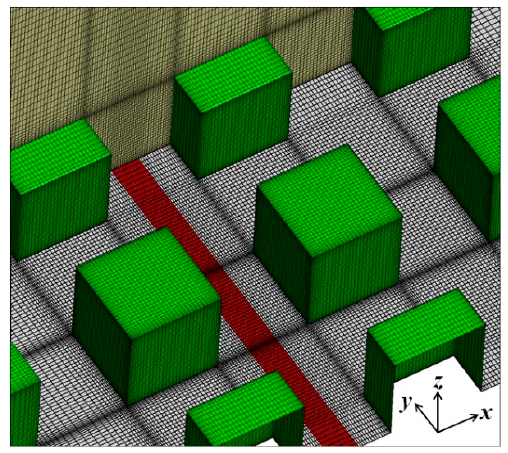
Figure 5. Computational meshes.